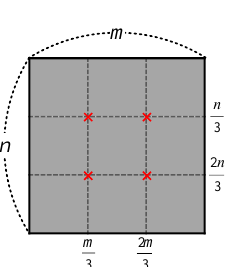
Figure 7. Insert four peak points into one template block. The points are inserted at the third division point so that the intervals are the